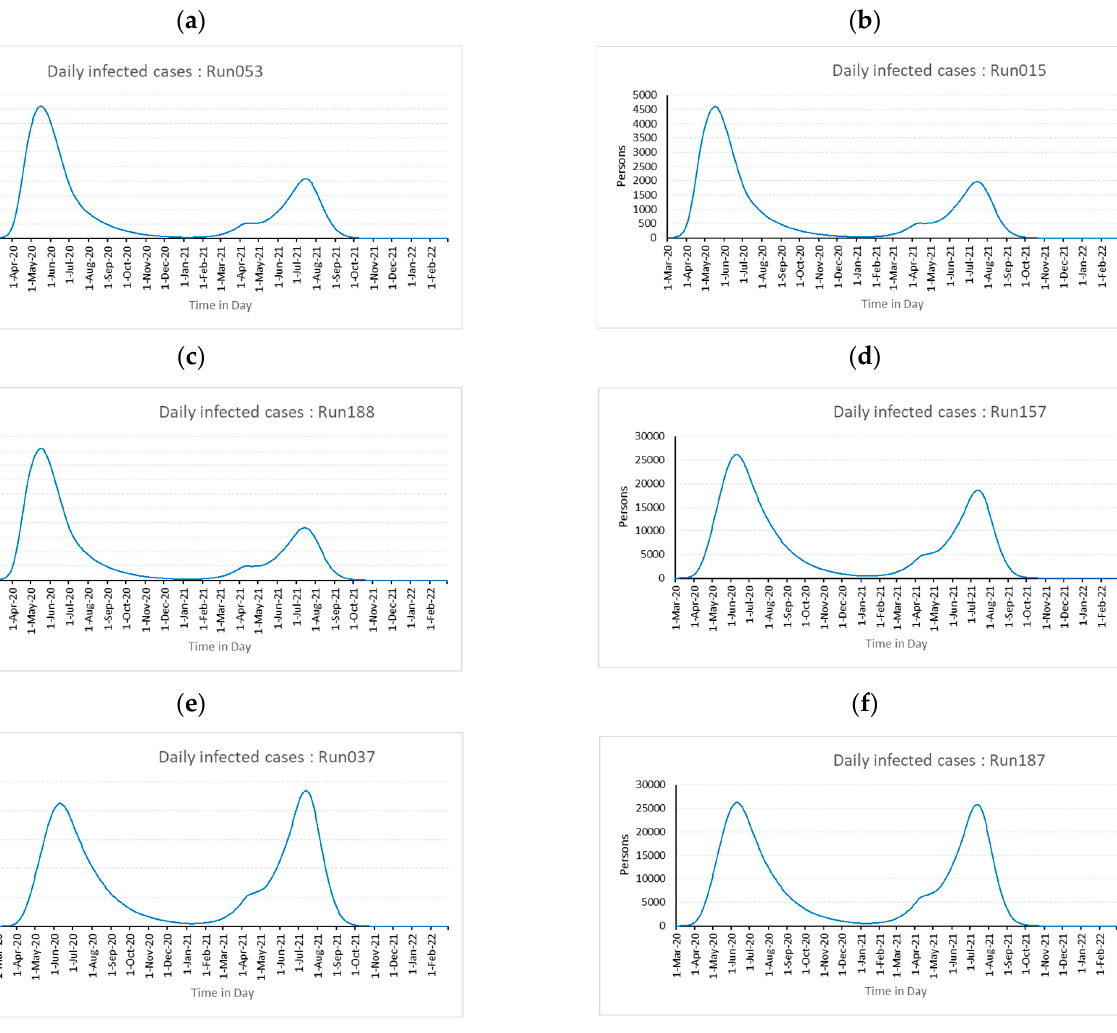
Figure 5. Daily infected cases for simulation ( a ) Run053, ( b ) Run015, ( c ) Run188, ( d ) Run037, ( e ) Run157, and ( f ) Run187.